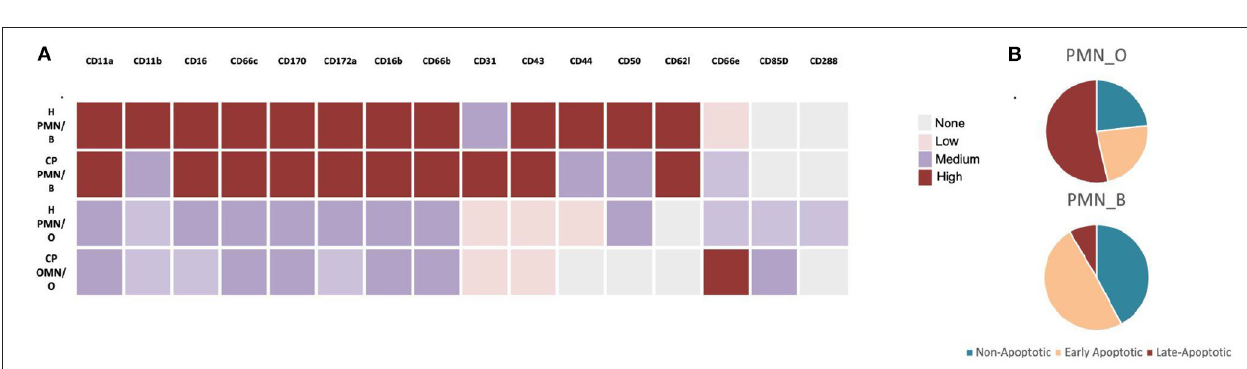
FIGURE 1 | Oral endotoxin has the potential to prime or tolerize the infiltrating neutrophil. In circulation, the neutrophil may contain bacteria and/or be exposed to enteric LPS (LPS E ) and subsequently migrate into tissues of the gingiva. Depending on the state of oral health, oral LPS (LPS O ) can shift phenotypes with the changes that arise during microbial dysbiosis. Depending on the neutrophil state of activation, the subsequent agonism or antagonism of TLR4 could either prime or tolerize the migrating neutrophil. In addition, the circulating neutrophil has been found to harbor altered bacteria in periodontitis, illustrated here as described by Emery et al. [ 18].